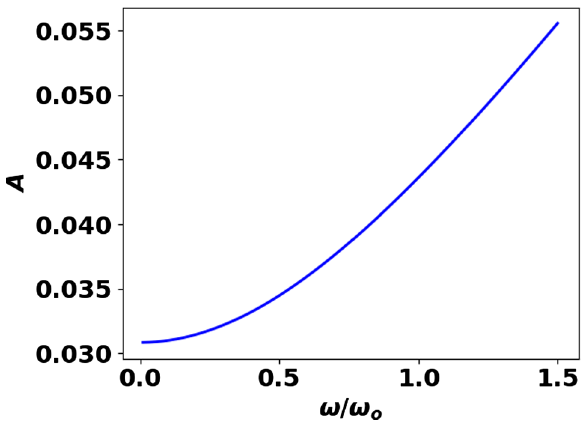
FIG. 7. Reduction in the path-length error amplitude as a function of noise frequency for an EOM-based feedback